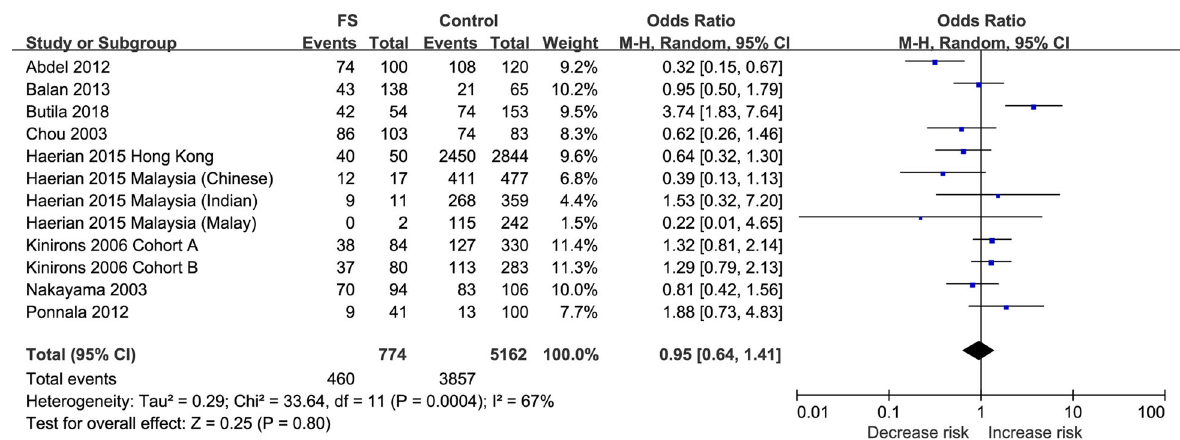
Fig. 2 Forest plot of the relationship between the GABRG2 rs211037 polymorphism and risk of FS. No significant association was observed